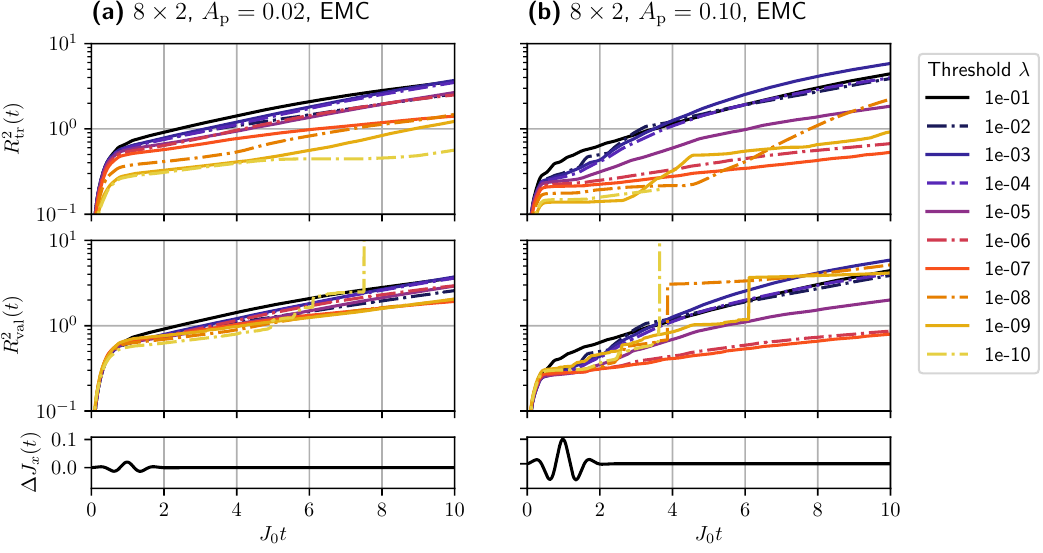
Figure 9: Integrated bare and validation TDVP error (16) over time with varying regularization (SVD threshold λ ) for the same trajectories as shown in Fig. 6(a),(b), i.e., using EMC sampling and with pulse strengths of (a) A The bottom panels show the time-dependent modulation ∆ J